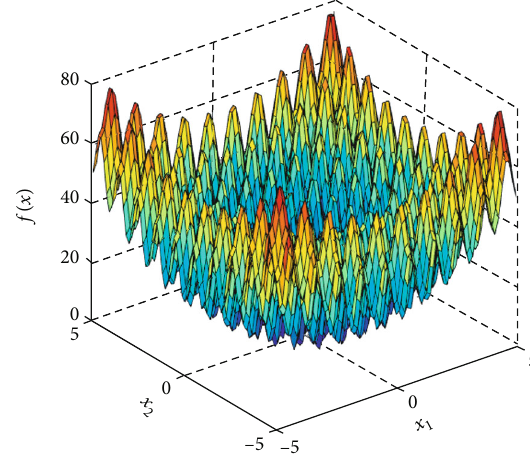
Figure 1: 2D Rastrigin